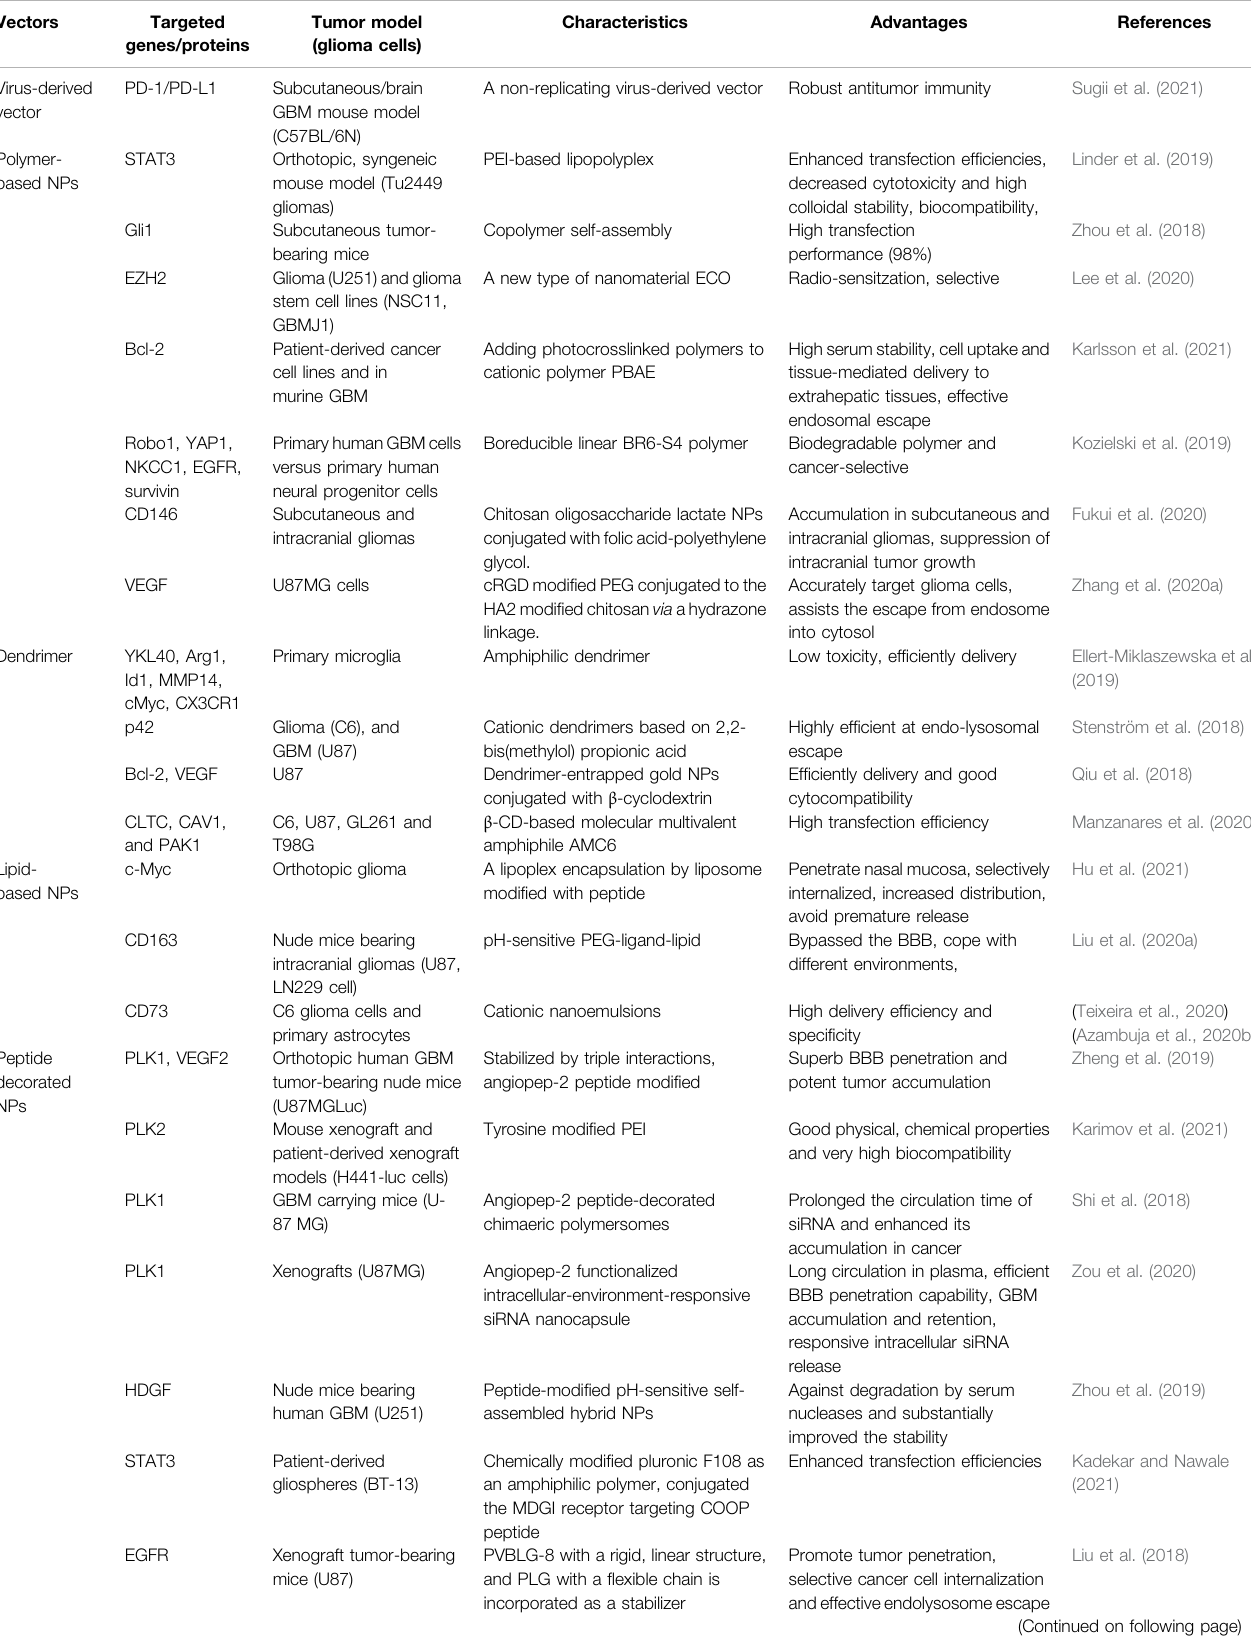
TABLE 1 | siRNA delivery strategies in